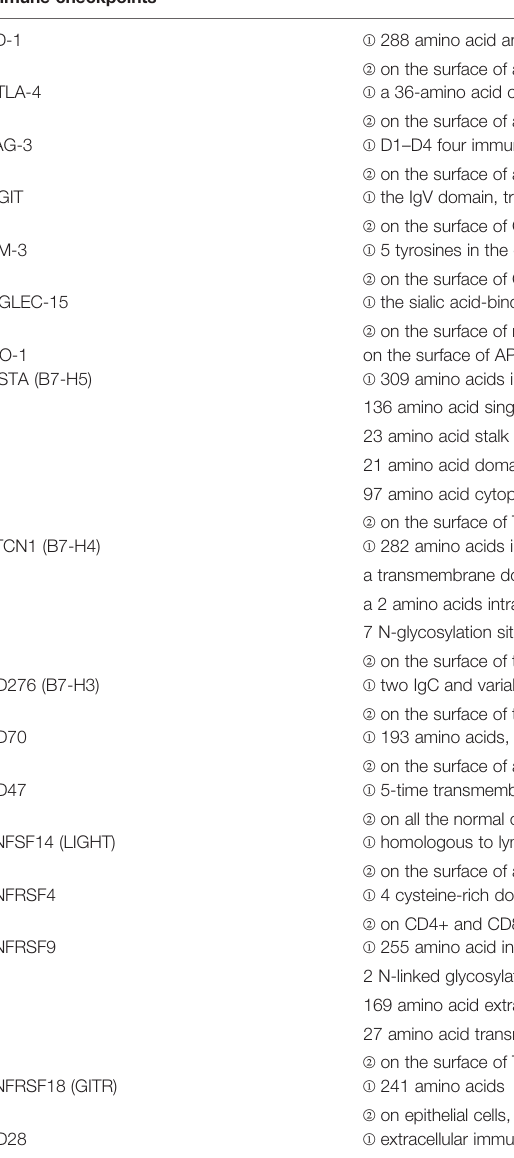
TABLE 1 | Immune checkpoints structure and expression. Immune checkpoints Structure and